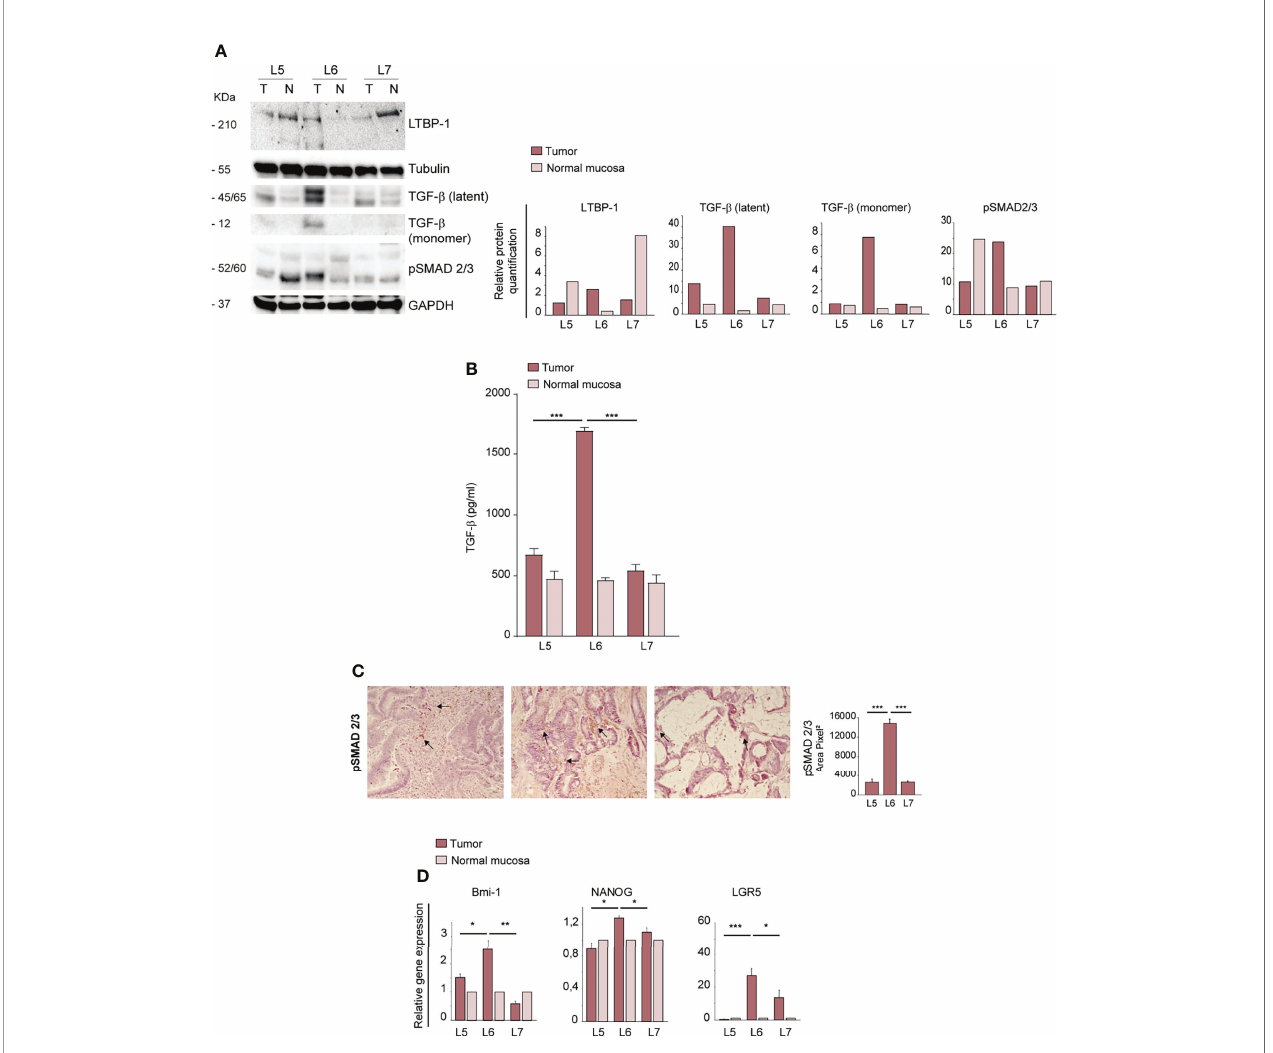
FIGURE 3 | Ortho-PDX generation is associated with TGF- b pathway activation and increased expression of stemness-associated factors in the parental tumor. (A) Left: immunoblot analysis of TGF- b , LTBP-1 (Latent-transforming growth factor beta-binding protein 1), Latent TGF- b , active TGF- b and phosphorylated SMAD 2/3 (pSMAD 2/3) on whole lysates of normal mucosae (N) and patient tumors (T). Tubulin and Glyceraldehyde-3-phosphate dehydrogenase (GAPDH) were used as loading controls. Right: quanti fi cation of the immunoblot experiment shown on the left. (B) ELISA assay performed on lysates of normal mucosae (N) and patient tumors (T) showing active TGF- b concentration. ***P<0.001 from two-tailed t test. (C) pSMAD 2/3 staining of L5, L6 and L7 tumor sections and quanti fi cation of 5 fi elds/section. Magni fi cation 20x. Bar 50 m m. (D) qRT-PCR analysis of Bmi-1, Nanog and LGR5 expression in normal mucosae and tumor tissues of CRC patients. Mean ± SD of 3 experiments. *P<0.05, **P<0.01 and ***P<0.001 from two-tailed t